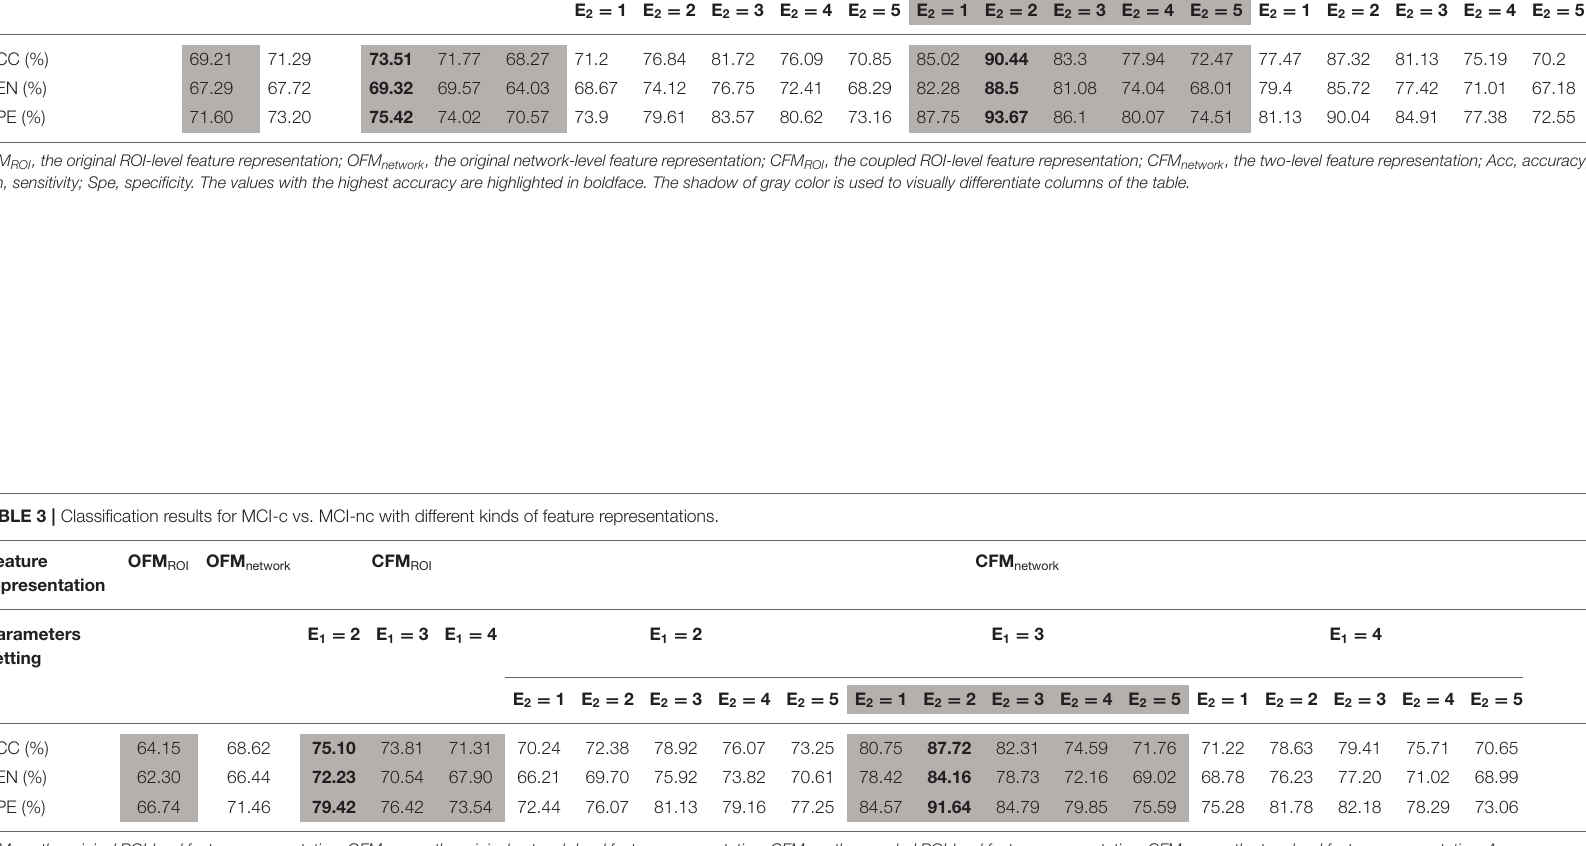
TABLE 2 | Classification results for AD vs. NC with different kinds of feature representations. Feature representation OFM ROI OFM network CFM ROI CFM network Parameters setting